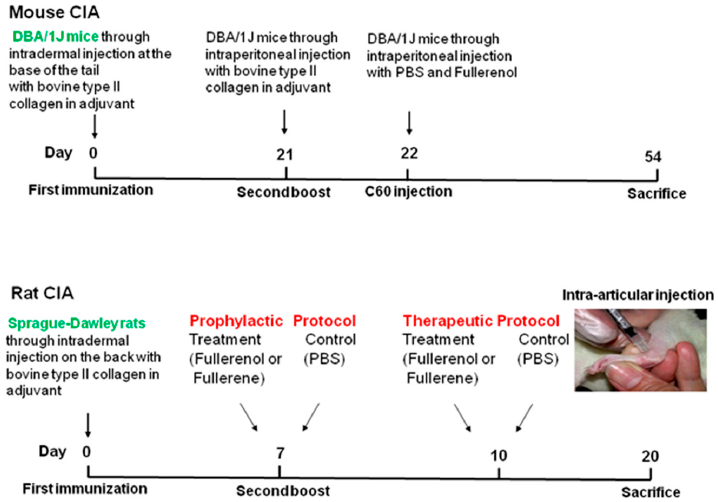
Figure 2. Timeline and procedure of collagen-induced arthritis (CIA) induction and treatment.